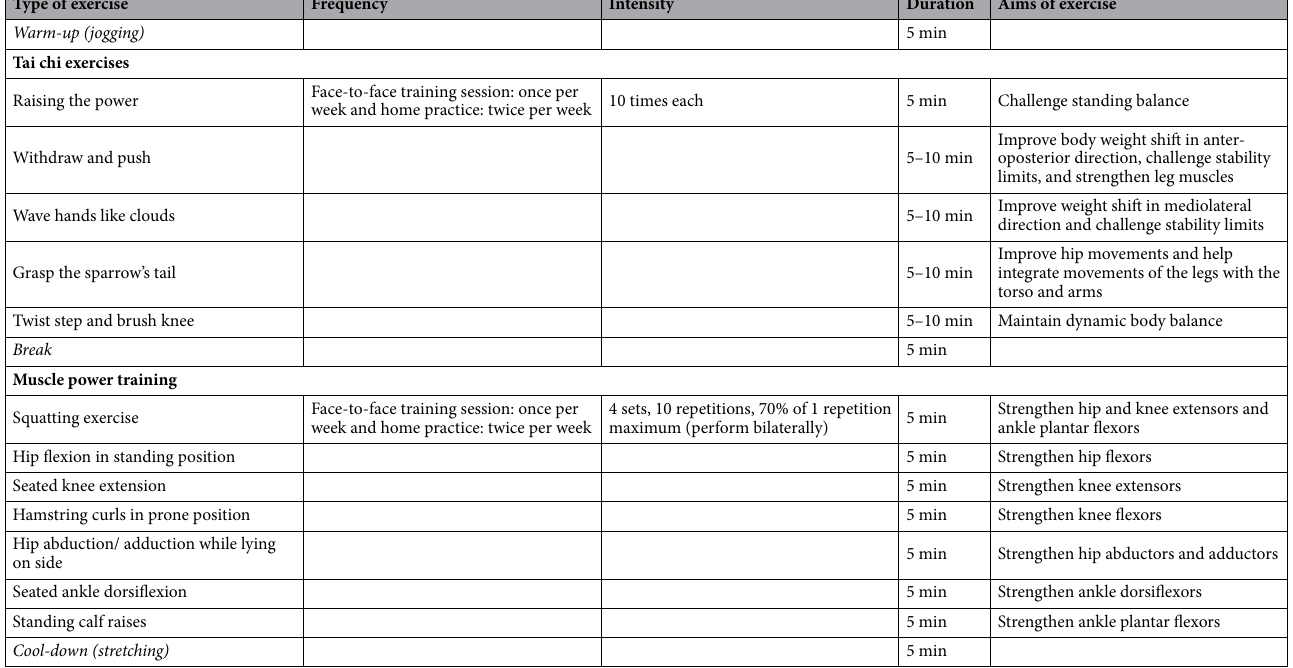
Table 4. The tai chi-muscle power training program to improve center of gravity control and leg muscle force production speed and the limits of stability of balance control in children with DCD. The tai chi-muscle power training group followed the entire protocol, the tai chi group received only the simplified tai chi program, and the muscle power training group received only the muscle power training. All three intervention groups received a total of 90 min of training (repeated practice) per